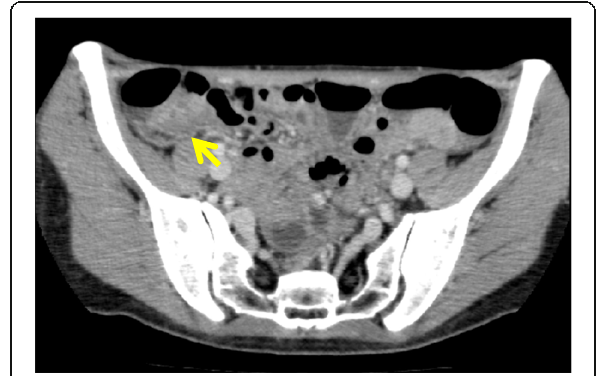
Fig. 3 The appendix could not be confirmed, and twitching and hardening of the serosa (arrow) were observed in the ileocecal